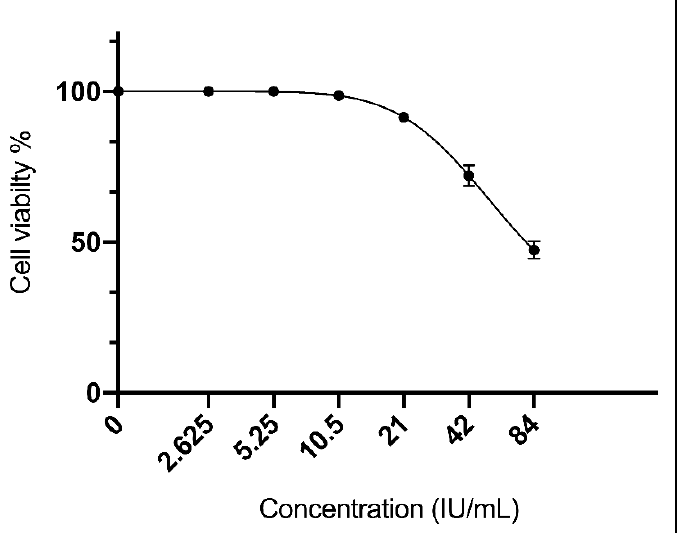
Figure 5 . Viability response of WI-38 cell line against serial two-fold dilutions of purified asparagi- nase from L.theobromae . from L. theobromae